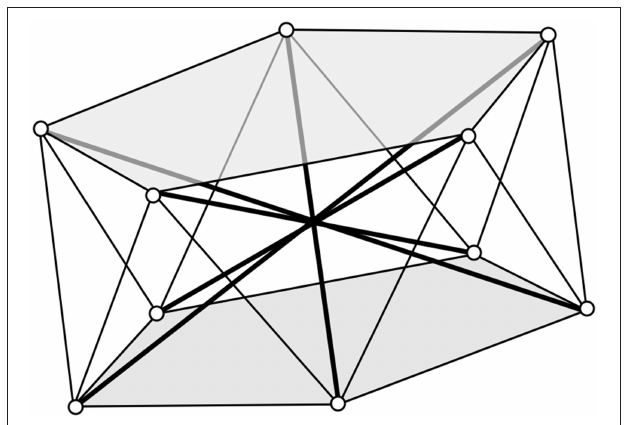
FIGURE 11 | A centrally symmetric framework with the shape of a pentagonal antiprism (with highlighted bases), see Theorem 7.